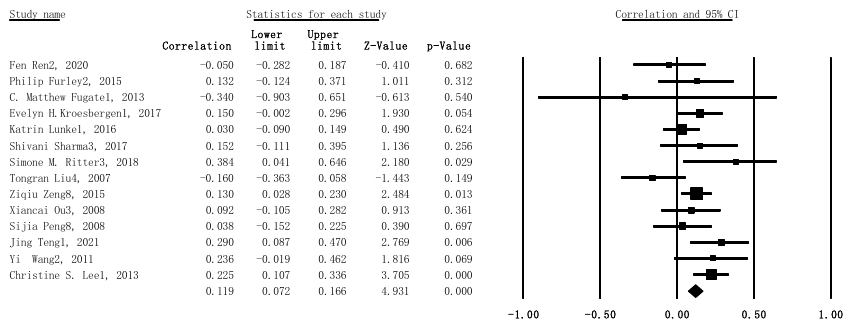
Figure 3. Forest plot with 95% confidence intervals and weights for subgroup meta-analysis, concern- ing the association between verbal WMC tasks and creativity. Larger positive effect sizes indicate that increased creativity ability is related to verbal